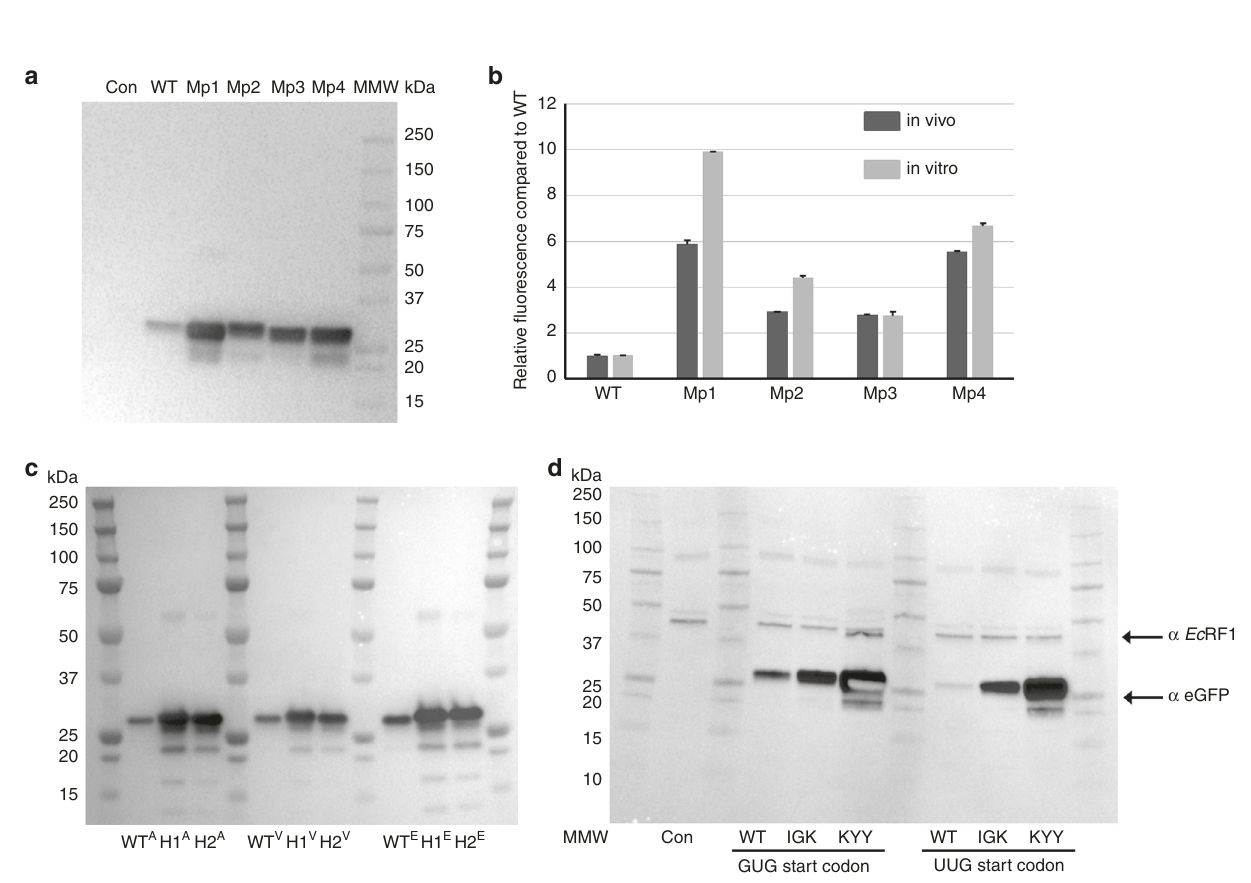
Fig. 4 Analysis of the effect of motifs in in vitro and in vivo bacterial expressions assays. a Western-blot analysis of NEB Pure Express in vitro expression of eGFP constructs with motif 1 AADUAU in different positions coding for amino acids 3 – 5. Mp1 indicates motif1 in position 1, Mp2 indicates motif1 in position 2, Mp3 indicates motif1 in position 3 and Mp4 indicates motif1 in position 4, where insertion positions are de fi ned as in Fig. 3c. Wild-type eGFP (WT) control is indicated. Five percent of is analyzed. Kinetics of in vitro translation reaction is shown in Supplementary Fig. 13. b Relative eGFP fl uorescence from in vitro and in vivo expression of eGFP constructs with AADUAU motif in different position compared to the wild-type eGFP construct. The fl uorescence ratio of each construct is plotted as a fold increase over the corresponding WT. Endpoint fl uorescence for in vivo induction in E. coli cells (Supplementary Fig. 12) and in vitro reaction (in Supplementary Fig. 13) were used to calculate ratios. Error bars represent standard deviation. c Western- blot analysis indicates that the N-terminal rule does not in fl uence the expression of eGFP variants from pBAD single copy vector in vivo in E. coli Top10 cells. Two high expression variants H1 (NCT) and H2 (LQI) and WT eGFP constructs are indicated. Letter in superscript indicates amino acid in the second position (A-alanine, V-valine, E-glutamic acid). d In vivo analysis of near cognate start codons GUG and UUG eGFP variants. eGFP antibody (JL-8, Clontech), E. coli peptide release factor I ( α EcRF1), anti-mouse and anti-rabbit HRP-conjugated secondary antibodies were used to visualize the expression of eGFP and normalization of western blot data, respectively. BioRad Precision Plus marker is indicated in